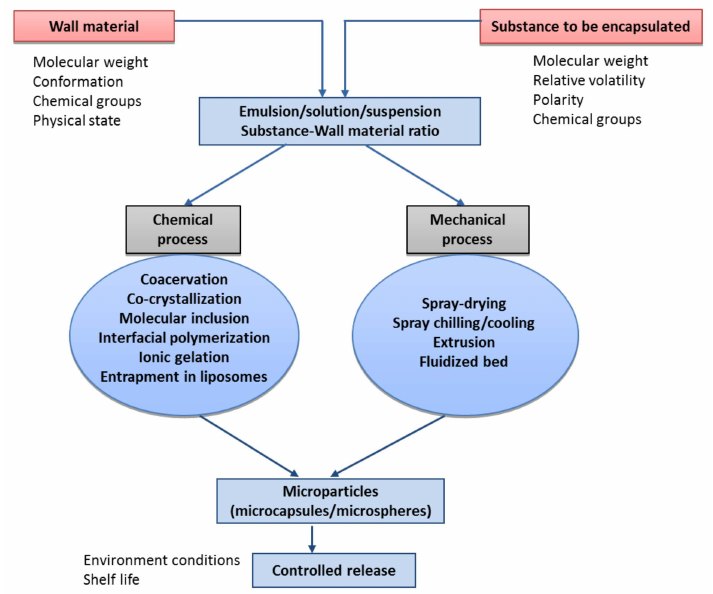
Figure 2. A schematic illustration of different processes of encapsulation used in food and flavour industries (adapted from Madene et al.